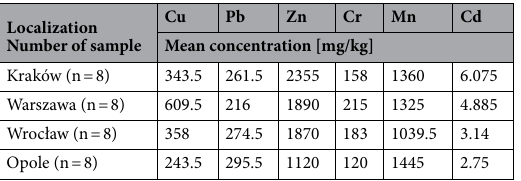
Table 3. Concentration of Cu, Pb, Zn, Cr, Mn and Cd in fraction < 20 µm of bike trail dust.